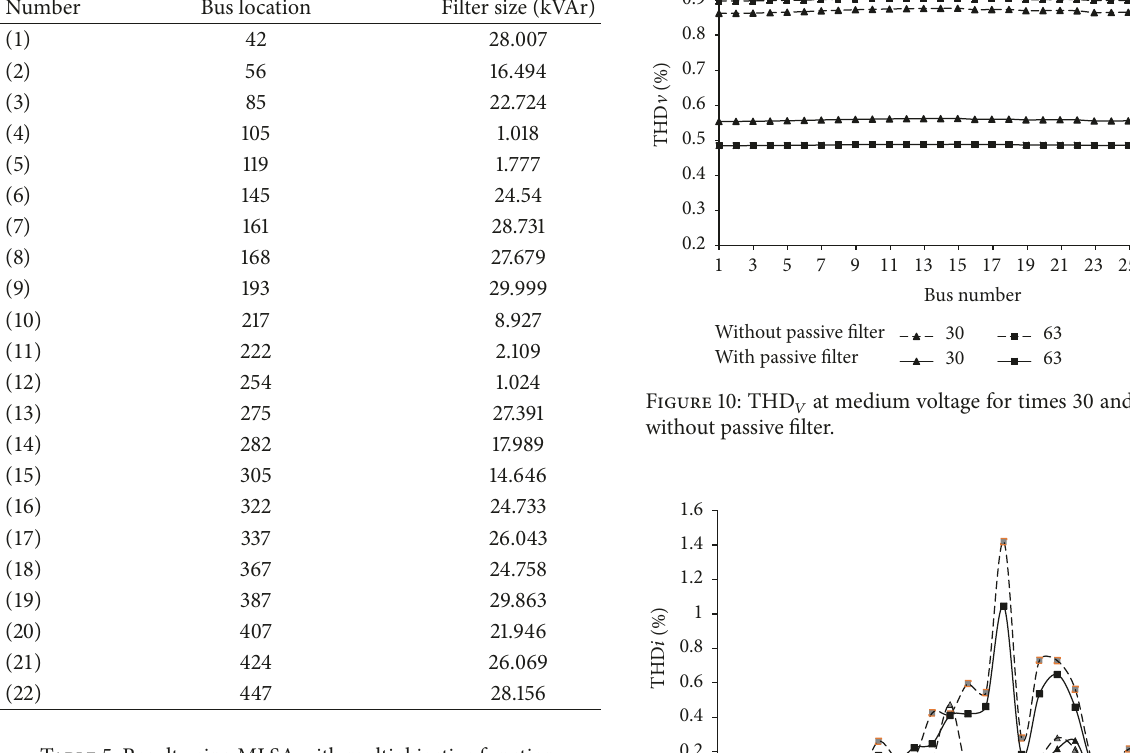
Table 5: Result using MLSA with multiobjective function. Function